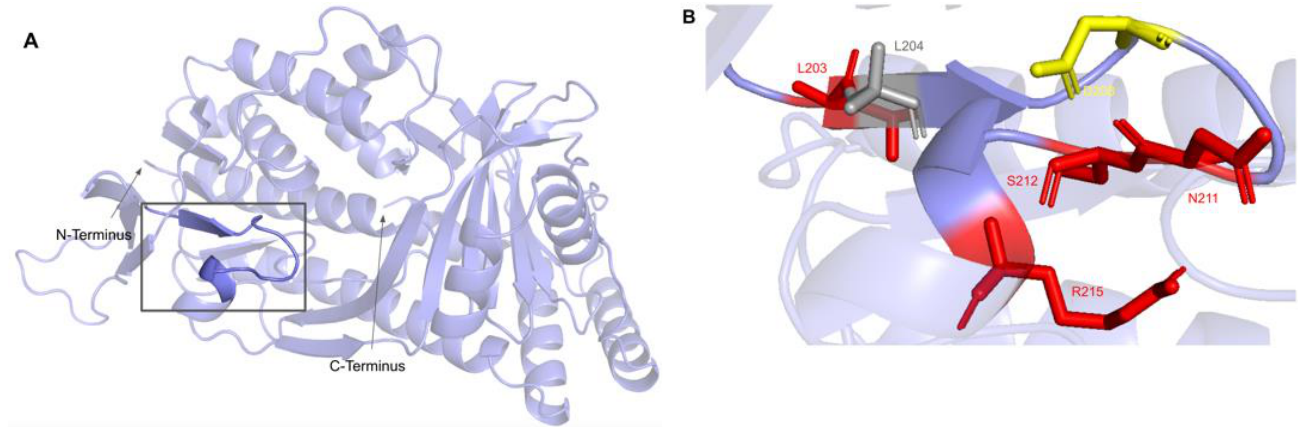
Figure 22. SNVs found in the COQ6 NAD(P)H/FAD recognition sequence. ( A ) NAD(P)H/FAD recognition structure highlighted on COQ6 model, residues K203 to R215. Residues 1 – 35 have been truncated. ( B ) Locations of SNVs are depicted. Residues are colored according to their corresponding SNVs in Figure 19.